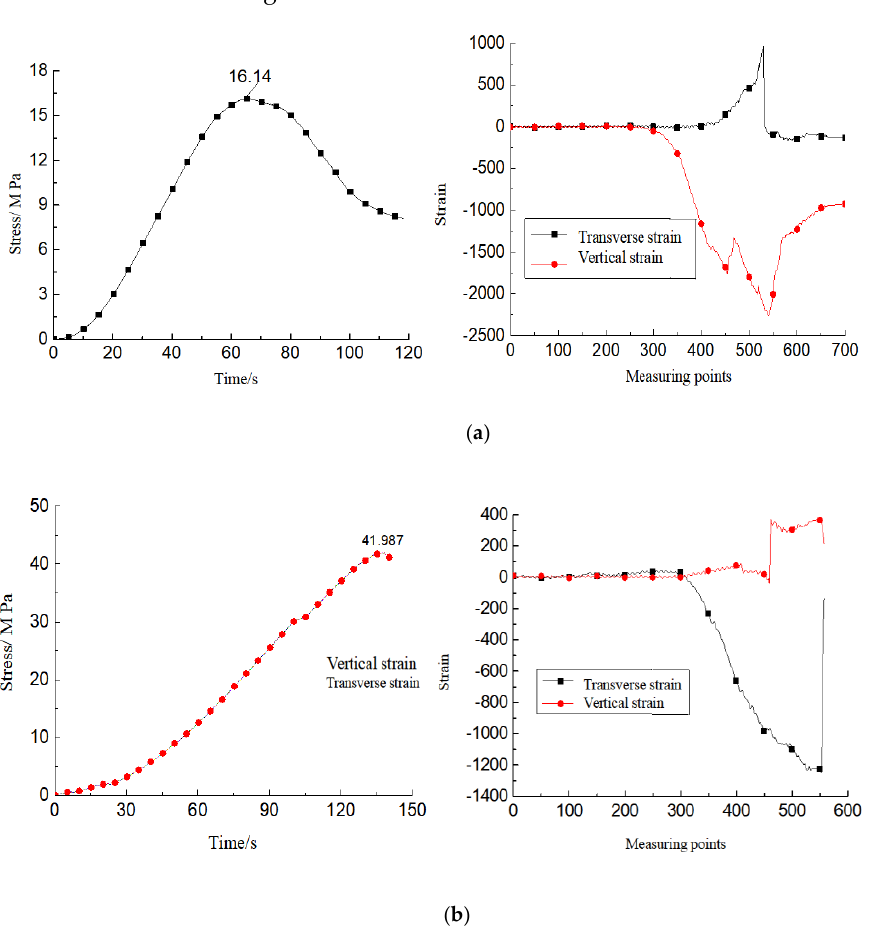
Figure 3. Static compressive strength of similar materials is the test result of Poisson’s ratio. ( a ) Mudstone-like material test results, ( b ) sandstone-like material test results.